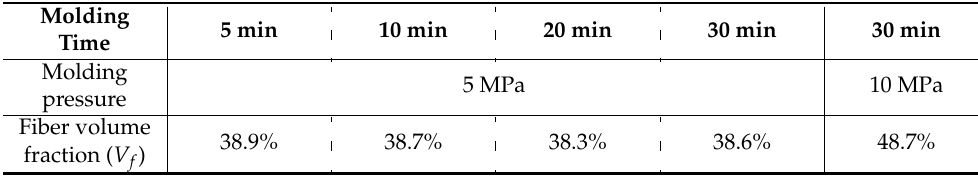
Table 7. Fiber volume fraction of each molded products.